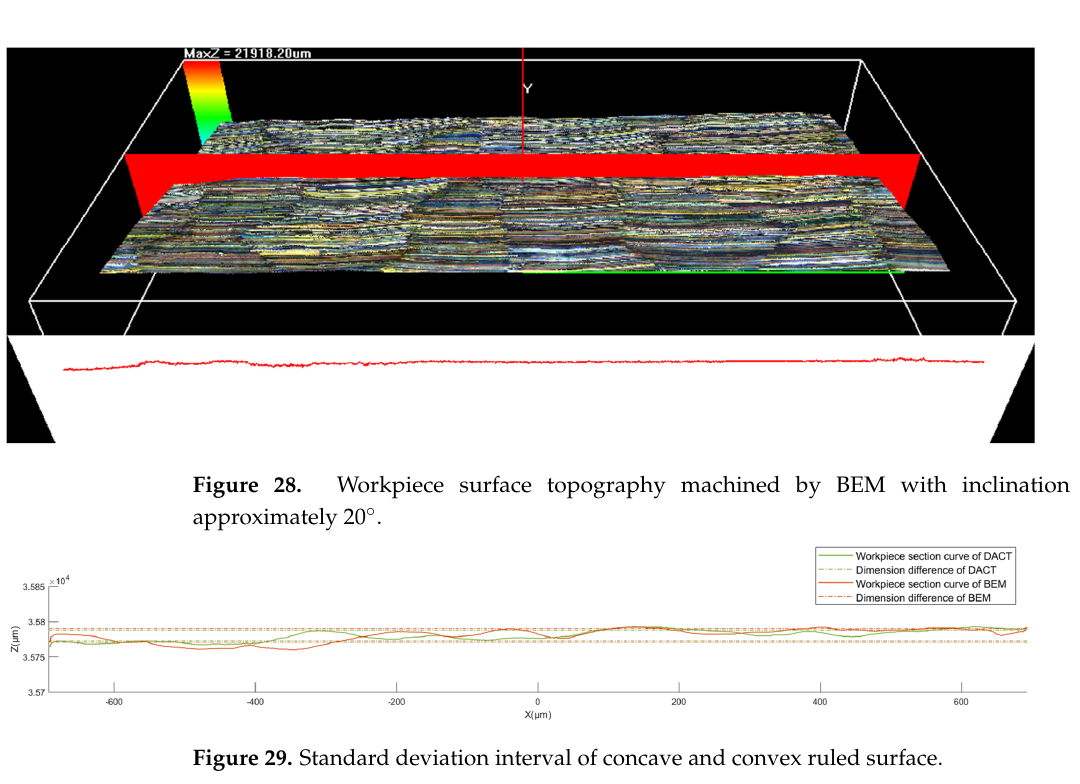
Through numerical analysis, the variance, the standard deviation, and the range of